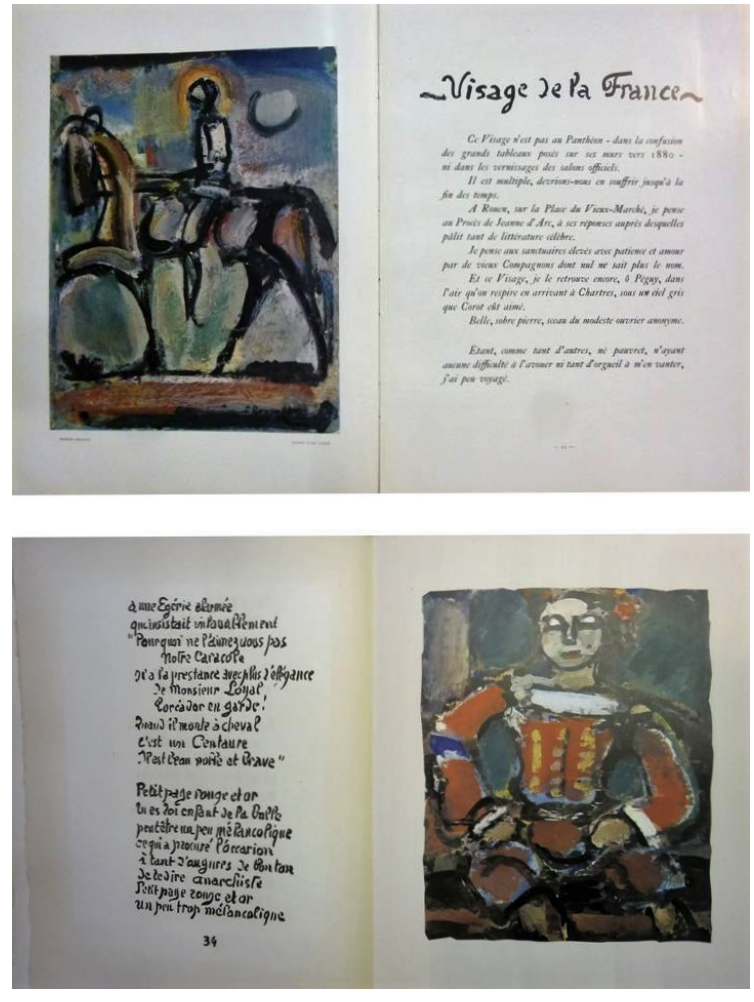
Texte de Georges Rouault, ‘Visage de la France’, publié dans la revue Verve , no. 8 (1940), et pages de son livre Divertissement (Paris: Éditions de la Revue Σ Δ EETE [OSDEETE], Verve , 1943), © ADGP, Paris, O